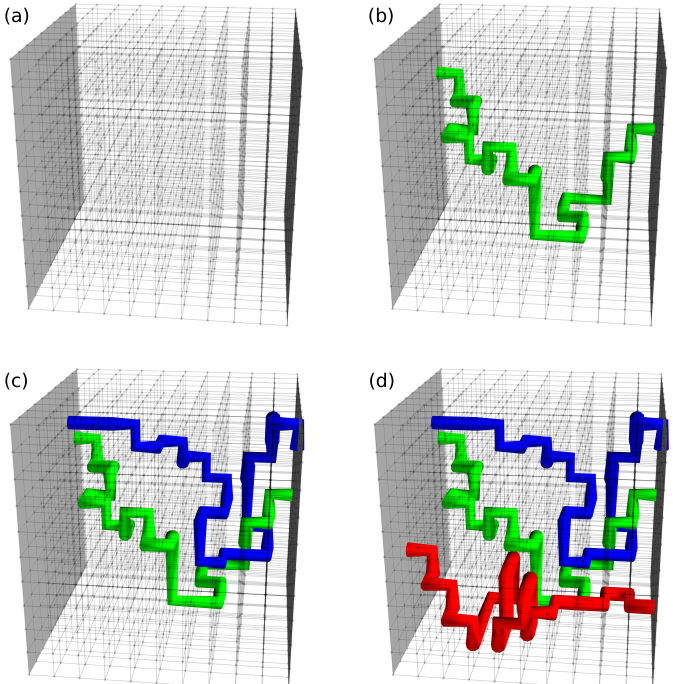
( 3 ) c ( 3 ) ( 3 ) ( 2 ) ) , ( T ( 2 ) ) , c , H c , H c 2 c 2